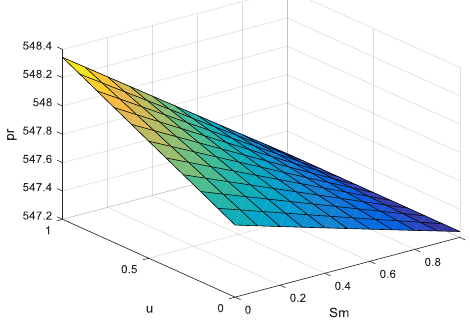
Figure 3. Effect of s m and µ on p r .